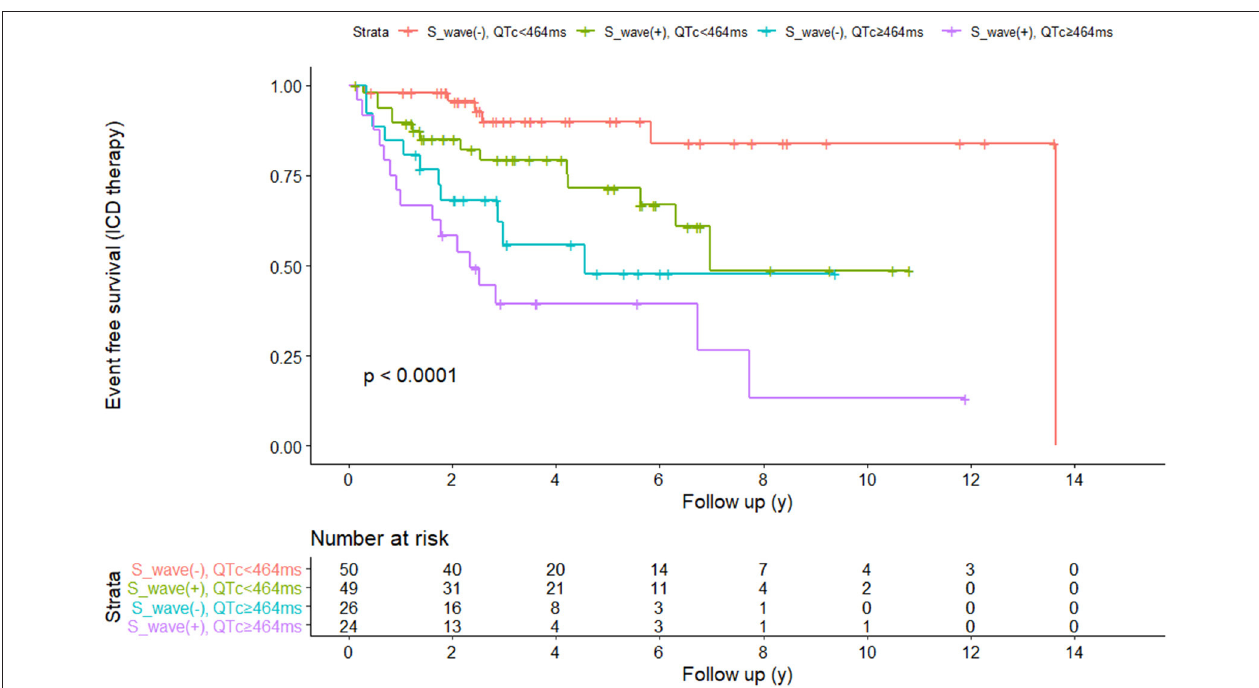
FIGURE 5 | Kaplan-Meier survival analysis curves were compared among the four